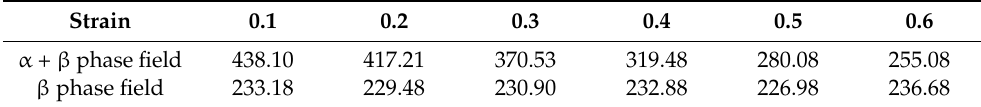
Table 4. Values of Q under different deformed conditions (kJ/mol).